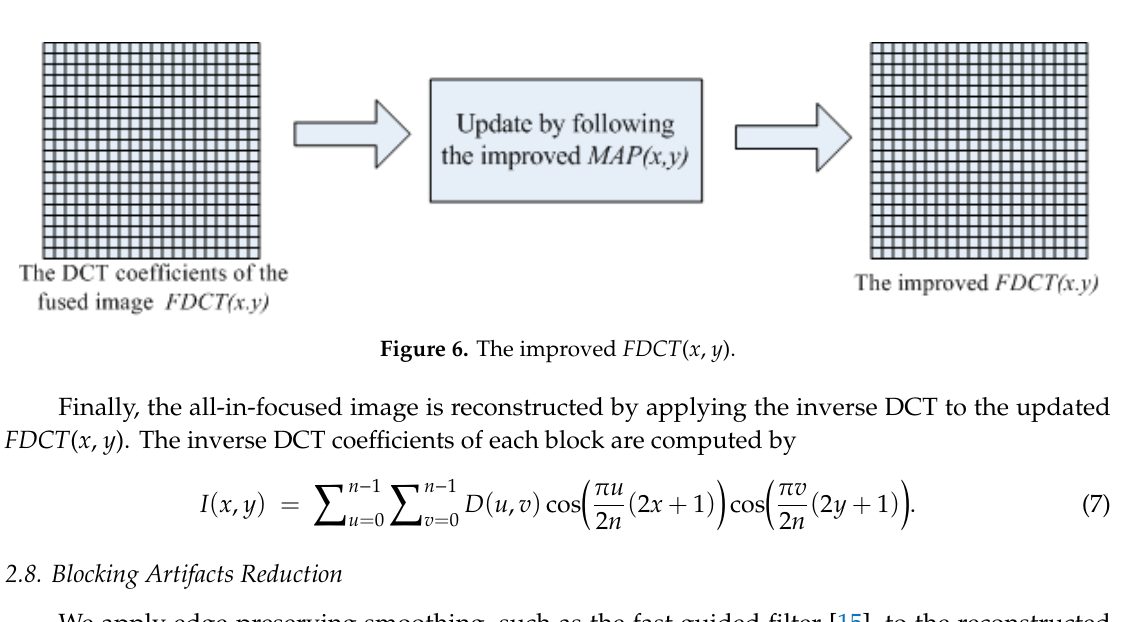
Figure 5. Majority filter in consistency verification to improve MAP ( x , y ).